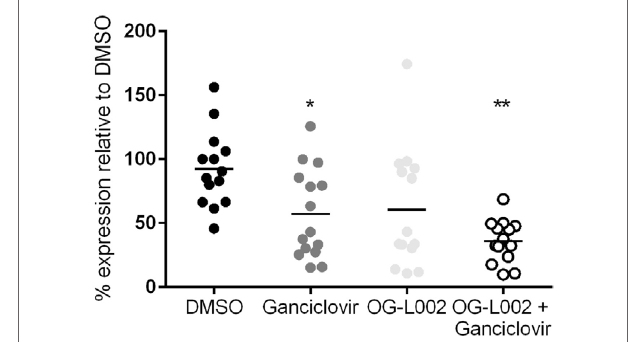
FigUre 5 | Effect of treatment on equine herpesvirus type 1 (EHV-1) viral load during infection of equine leukocytes. At 24 hpi, increased EHV-1 DNA copies per cell was detected in the presence of OG-L002 when compared with DMSO vehicle control (* p = 0.02) and ganciclovir (** p = 0.002). There was no difference ( p > 0.05) in EHV-1 viral load between DMSO vehicle control, ganciclovir or OG-L002 plus ganciclovir treatments. Note that y -axis has a log10 scale. Lines represent median